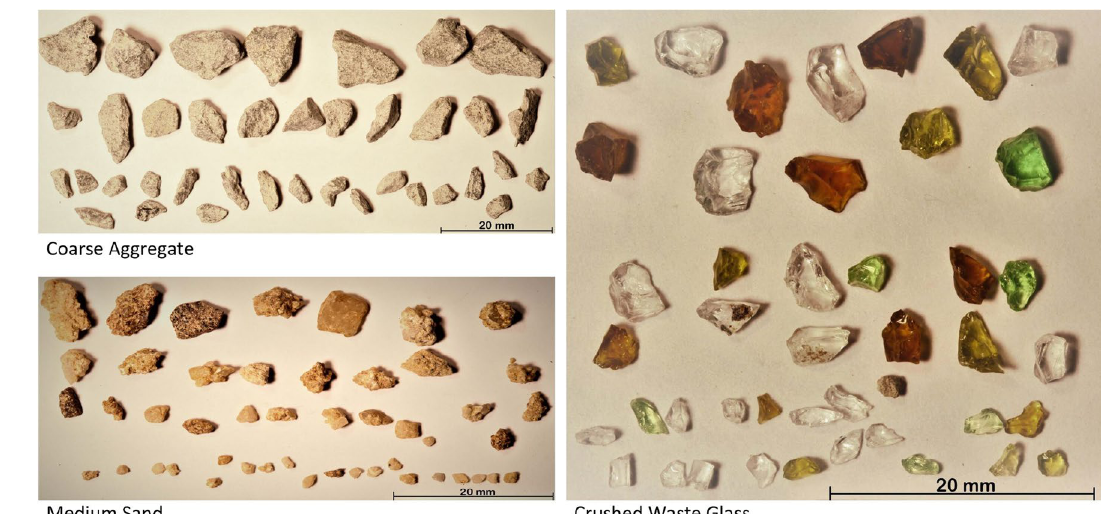
Fig. 3 Photographs of the aggregates’ size and shape used in this